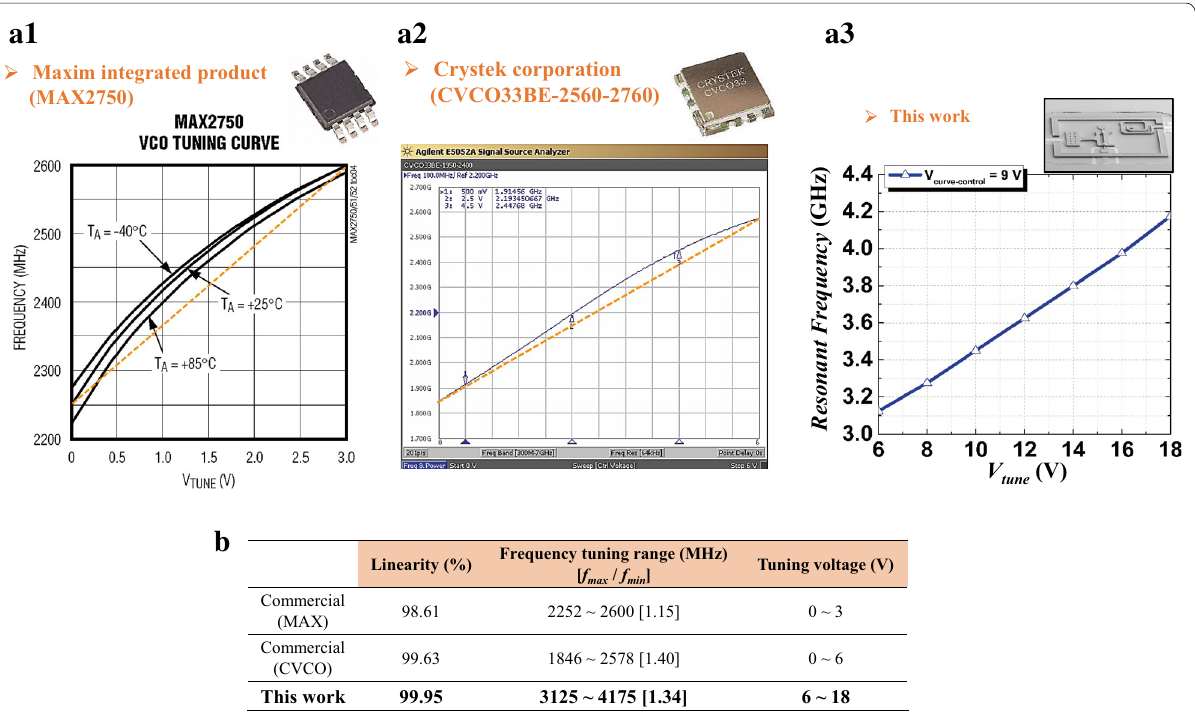
Fig. 8 Performance comparison. a f – V response of commercial VCOs and proposed LC module. b Data for linearity, frequency tuning range, and tuning